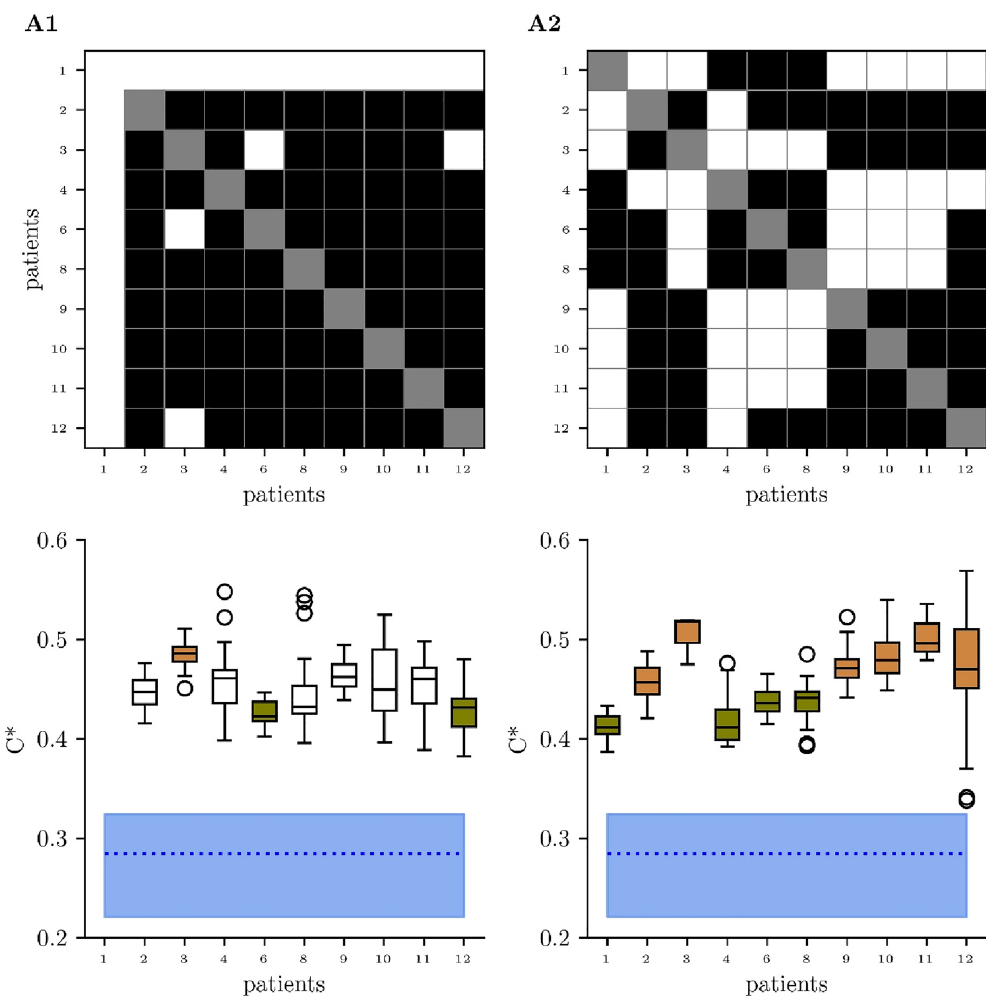
Figure 4. Results of between-patient comparisons (Scheffé tests; top) and distributions of age-corrected average clustering coefficients C * (bottom) at assessments ( A1 , A2 ). White rectangles indicate significant differences ( p < 0.05). Regarding the distributions of C *, bottom and top of a box are the first and third quartiles, and the black band is the median of the distribution, respectively. The ends of the whiskers represent the interquartile range of the data. Outliers are marked by an o-sign. Blue dotted lines and shaded areas indicate median and range of age-corrected average clustering coefficients C * of healthy controls. At assessment ( A1 ), C * of patient 3 (orange) differs significantly from the values of patients 6 and 12 (green). At ( A2 ), C * of patients 1, 4, 6, and 8 (green) differ significantly from the values of patients 2, 3, 9, 10, 11, and 12 (orange). The EEG recording of patient 1 during B1 at A1 had to be excluded from the analyses because of too many